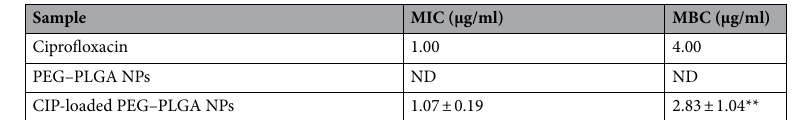
Table 3. The antimicrobial susceptibility test of the nanoparticles against E. faecalis. MIC Minimum Inhibitory Concentration of CIP (µg/ml), MBC Minimum Bactericidal Concentration of CIP (µg/ml), ND Not Detected, the results are represented as mean ± standard deviation (n = 9), ** refers to the significant difference between the CIP-loaded PEG–PLGA NPs and free CIP (** P < 0.01).